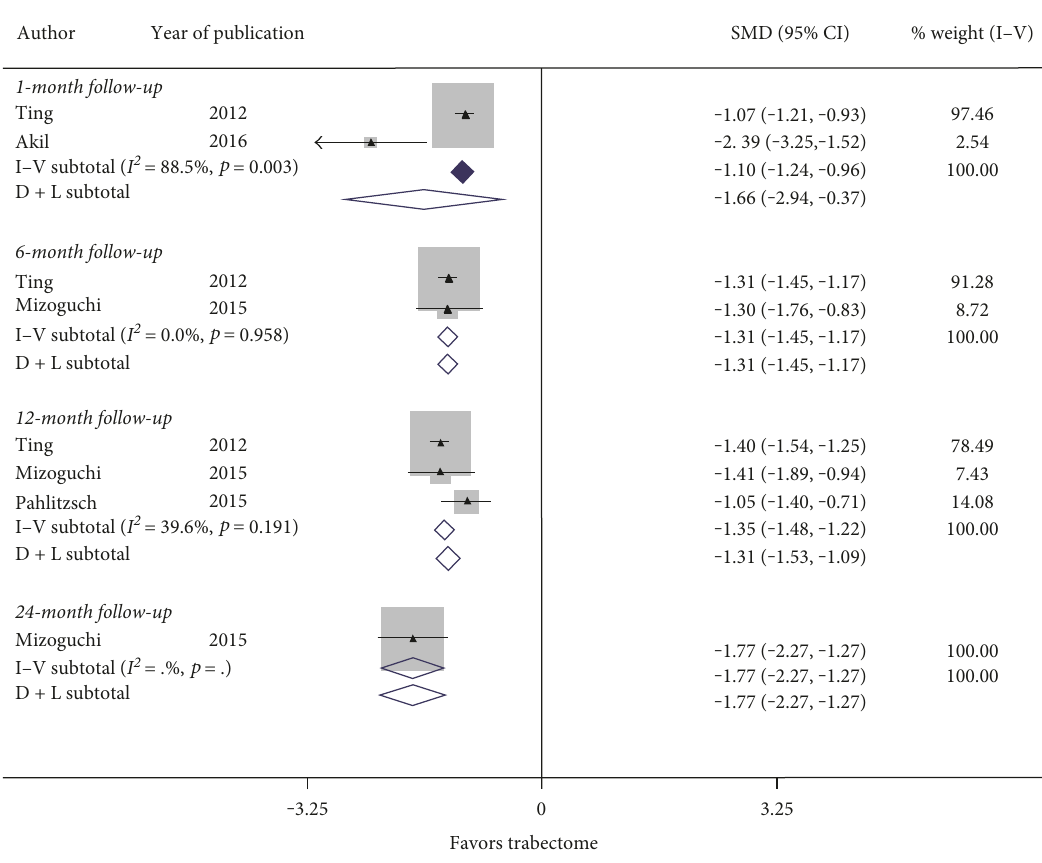
Figure 4: Forest plot for studies examining change in intraocular pressure (mmHg) by follow-up